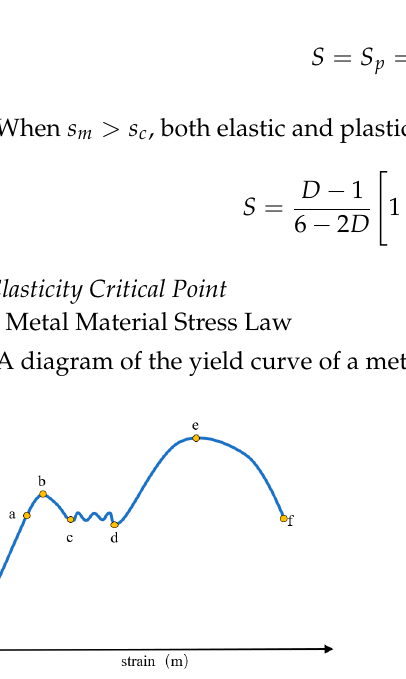
Figure 1. Yield curve of metallic materials.